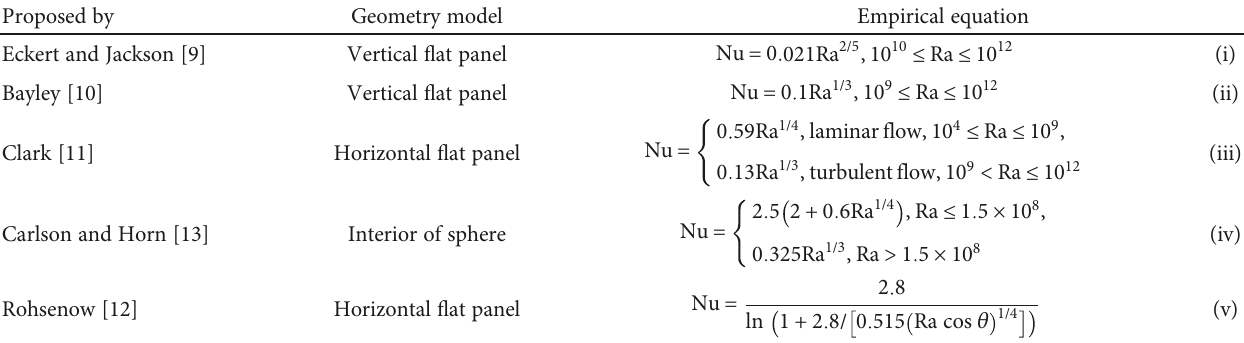
Table 1: Empirical equations for natural convection heat transfer.